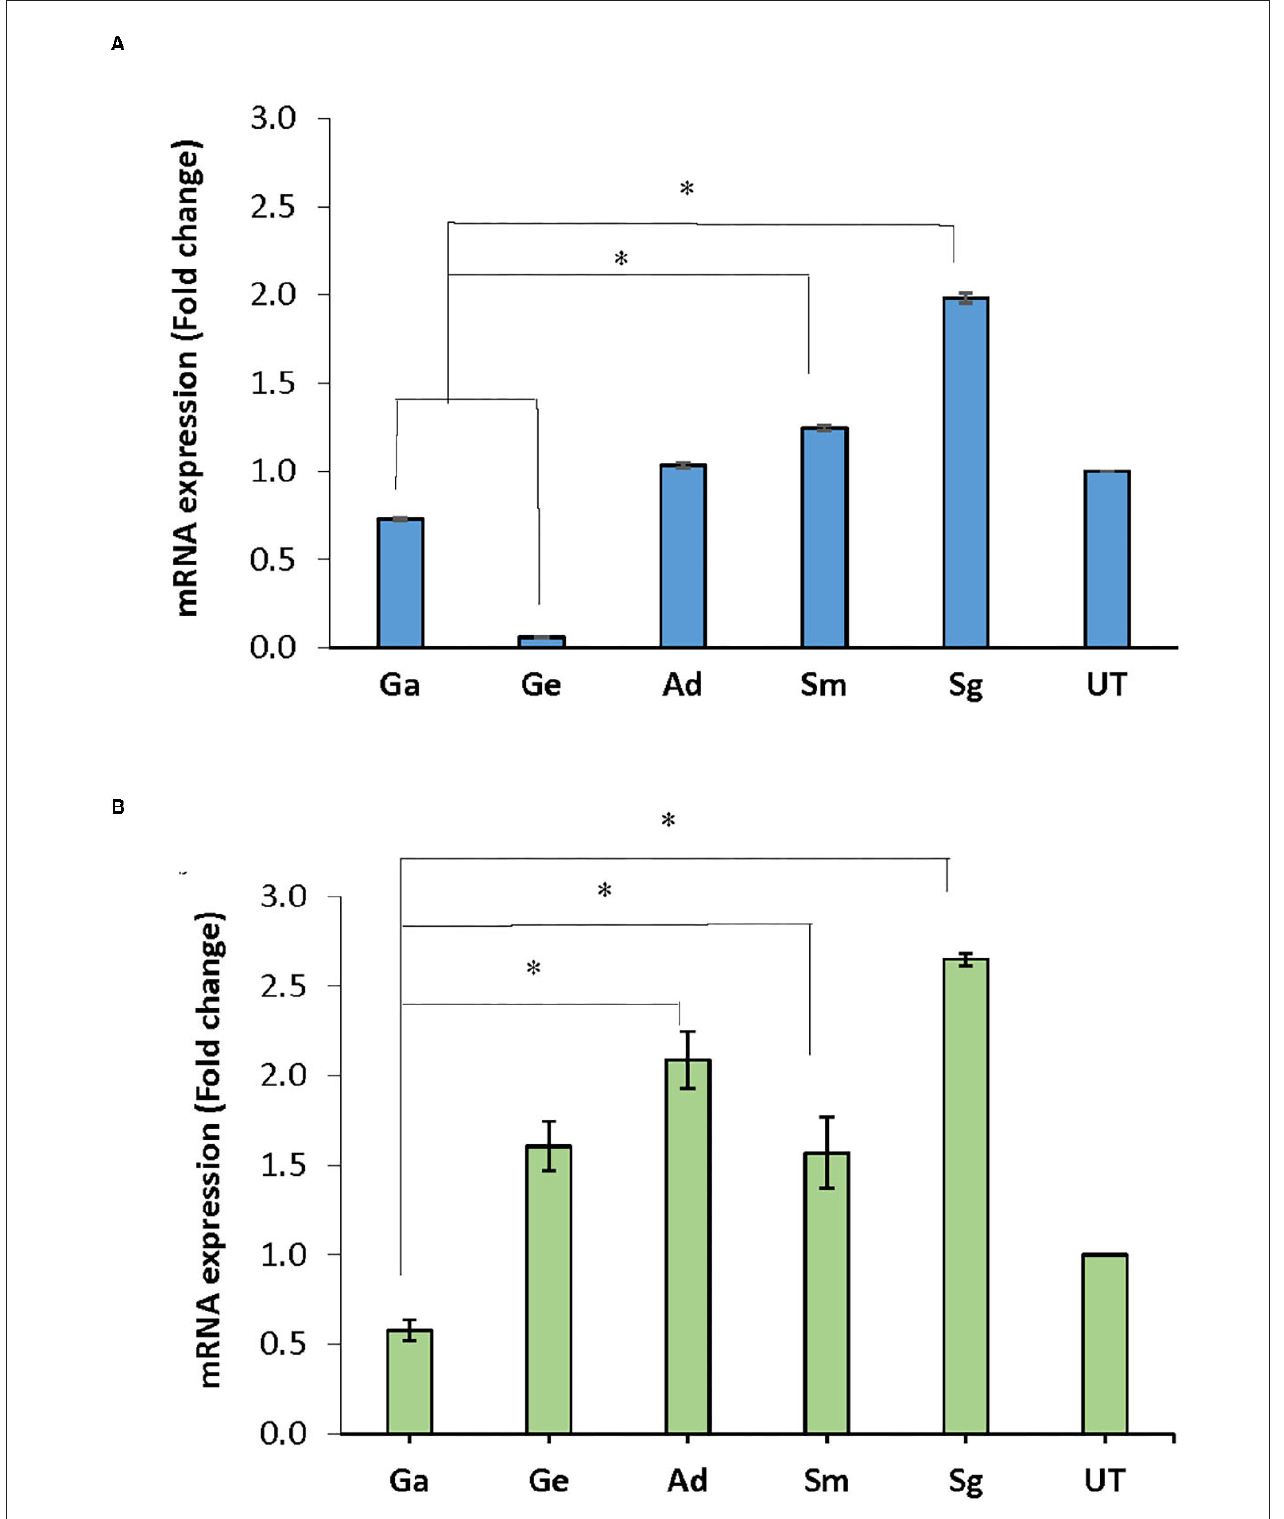
FIGURE 4 | mRNA expression of nox and fbp genes. Mature biofilms of all strains were treated with BITC (10 µ M) for 2h in 5% CO 2 at 37 ◦ C. The biofilms were scraped off from the wells, RNA later ® was added to the biofilms and preserved at − 80 ◦ C until used. RNA purified from the samples was converted to cDNA and expression of nox (A) and fbp (B) genes was assessed by Real-time PCR quantification. Ga, G. adiacens ; Ge, G. elegans ; Ad, A. defectiva ; Sm, S. mutans ; Sg, S. gordonii ; UT, untreated. * P < 0.05.